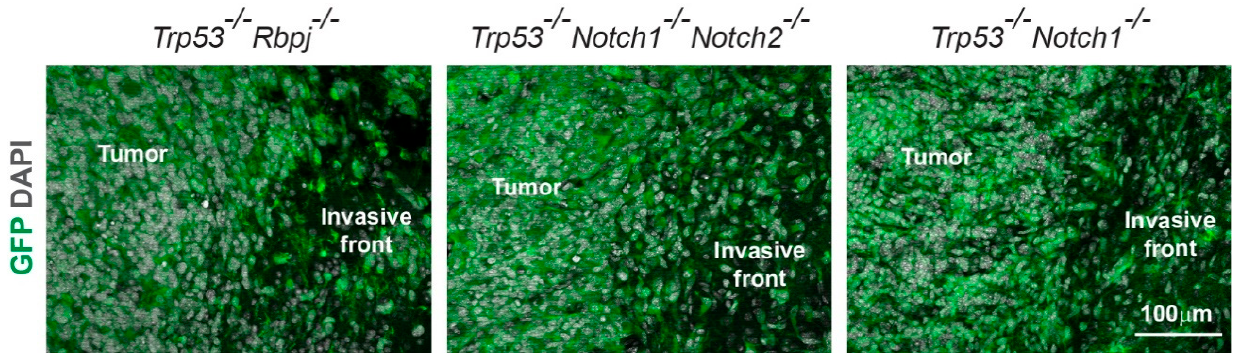
Figure 4. Pictures of the invasive front of Trp53 -/- Rbpj -/- , Trp53 -/- Notch1 -/- Notch2 -/- and Trp53 -/- Notch1 -/- tumors. The GFP expression from the Rosa-CAG::GFP Cre-reporter indicates derivation from Hes5 +